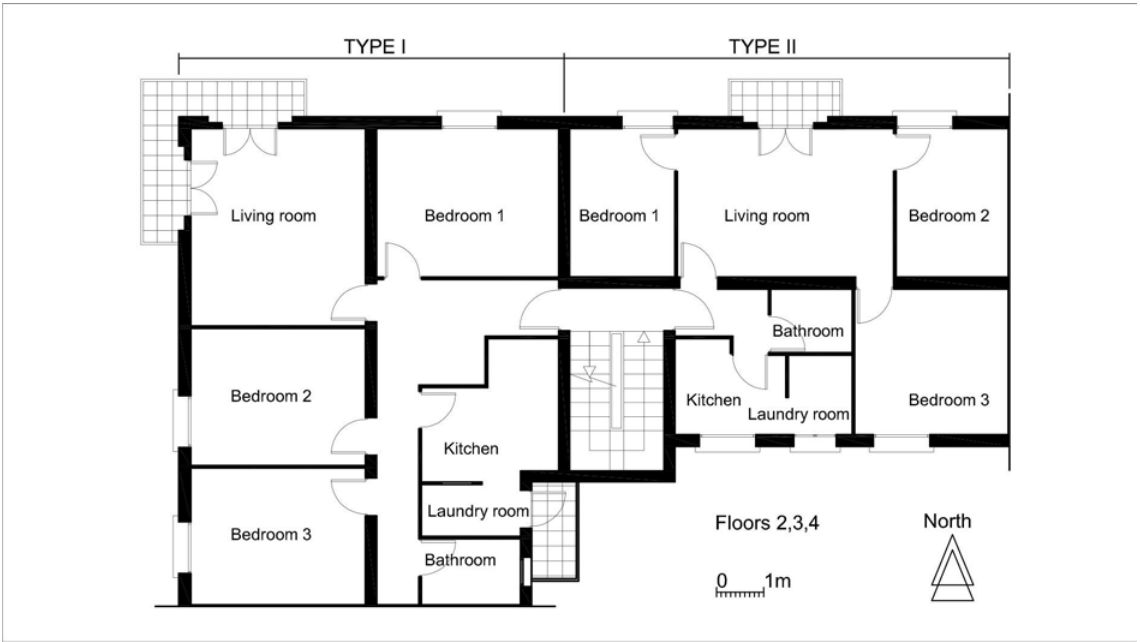
Figure 7. Floor plan of dwellings types I and